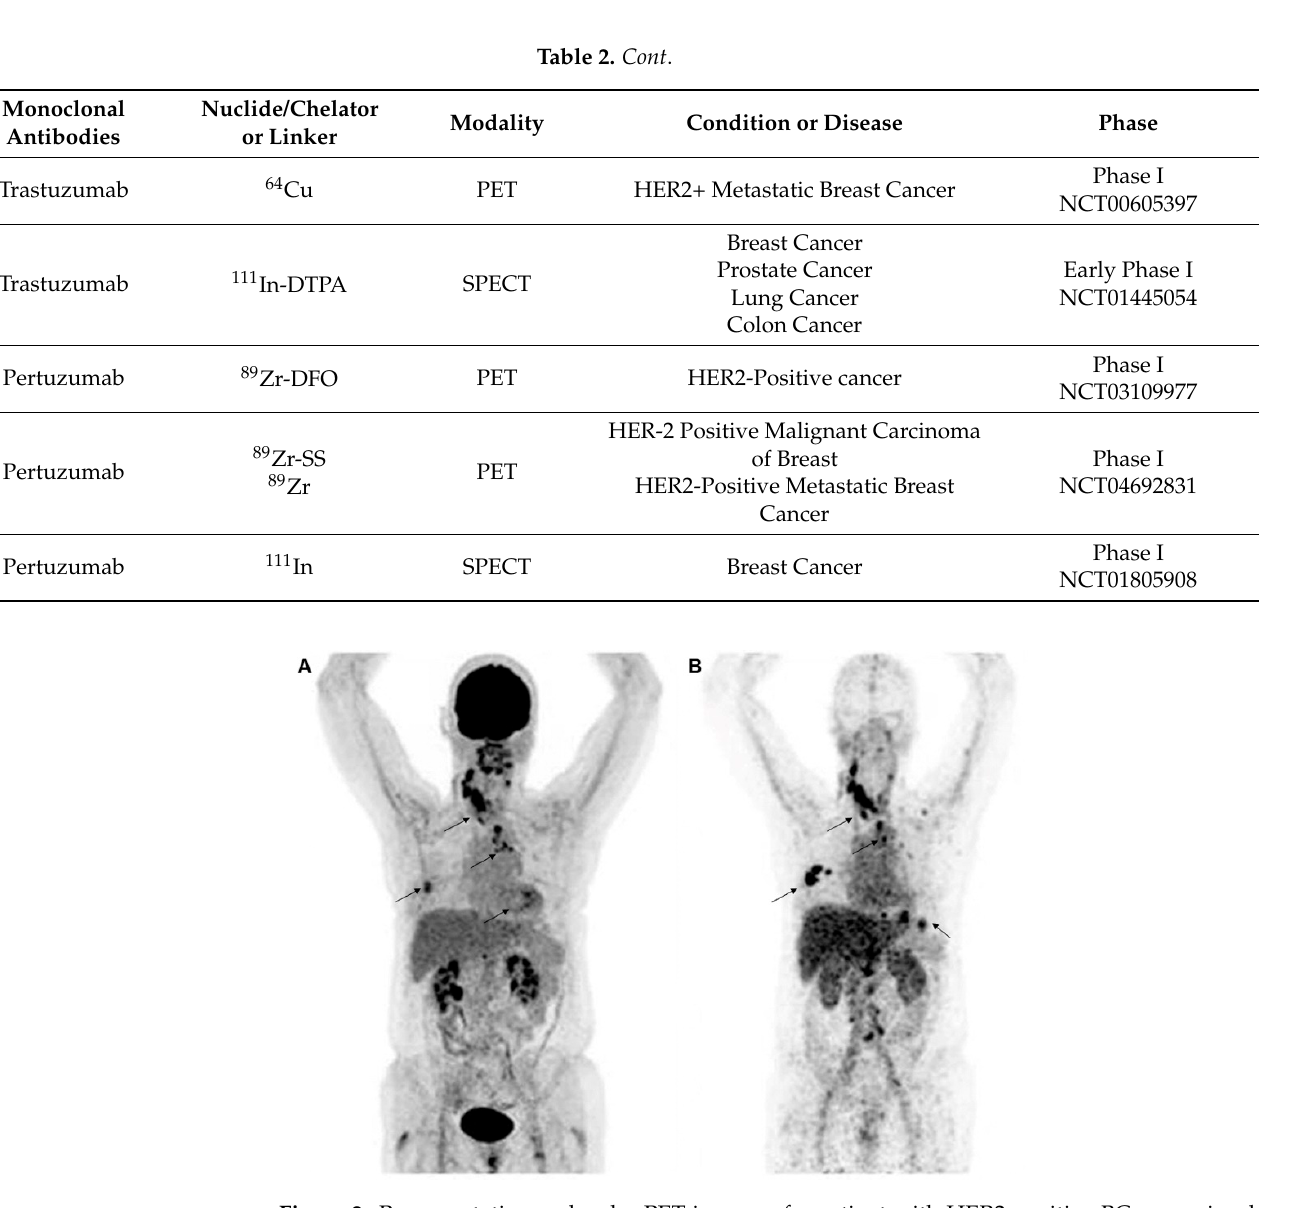
Figure 2. Representative molecular PET images of a patient with HER2-positive BC were visualized by 18 F-FDG ( A ) and HER2 ( B ) imaging with 89 Zr-trastuzumab. Images are reproduced with permission from [30].